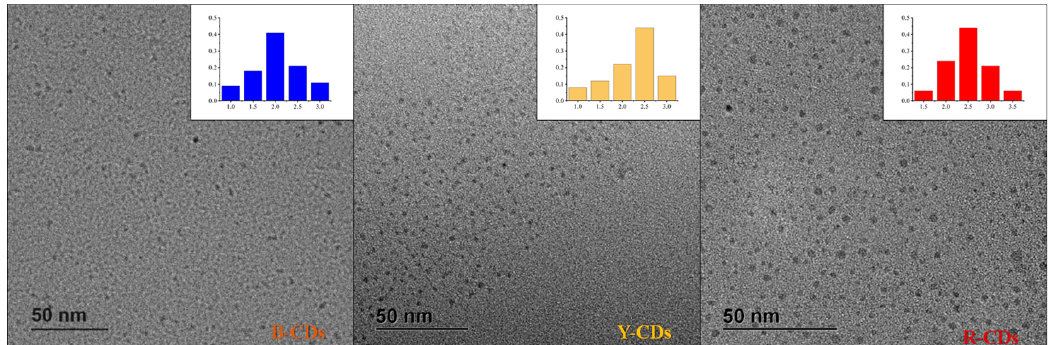
Figure 1. HRTEM images and the size distribution (insert) of MCDs.